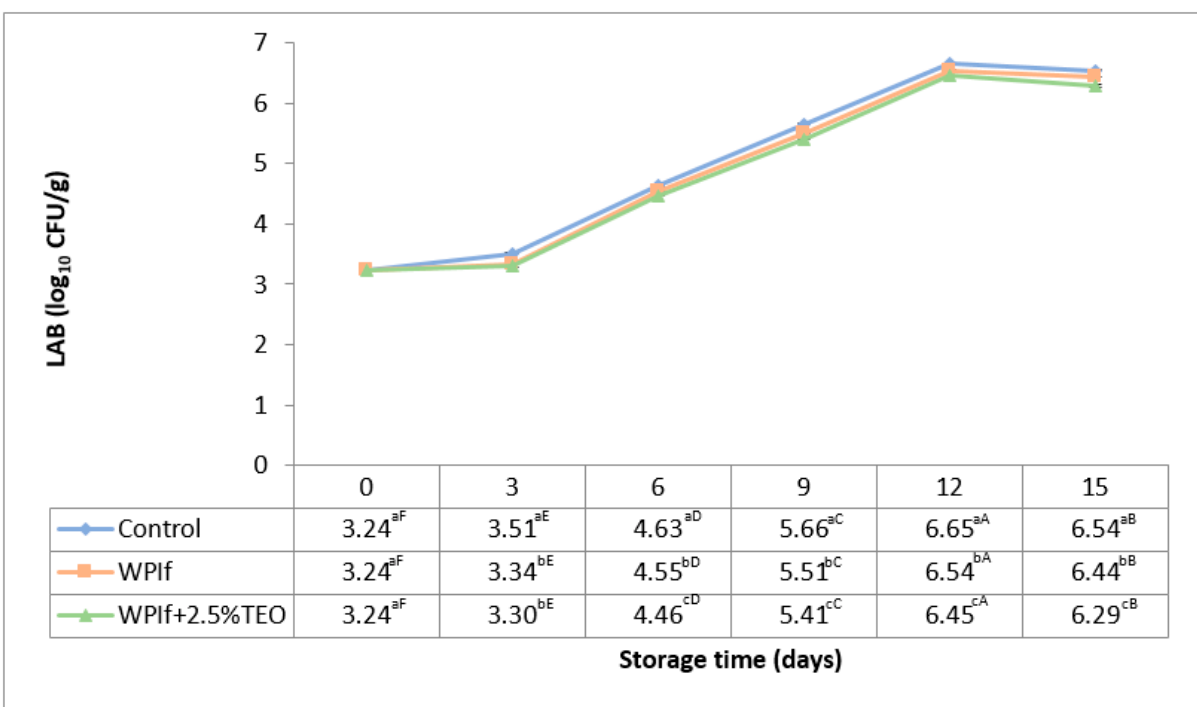
Figure 7. Changes in psychrotrophic count (PTC) of brook trout samples during refrigerated storage. Control-uncovered fish samples; WPIf-fish samples covered with WPI-based films; WPIf+2.5%TEO-fish samples covered with whey protein isolate-based films incorporated with 2.5% tarragon essential oil. Values are expressed as mean ± standard deviation of two replicates. Means that do not share a letter (lowercase letters on column and uppercase letters on row) are significantly different.